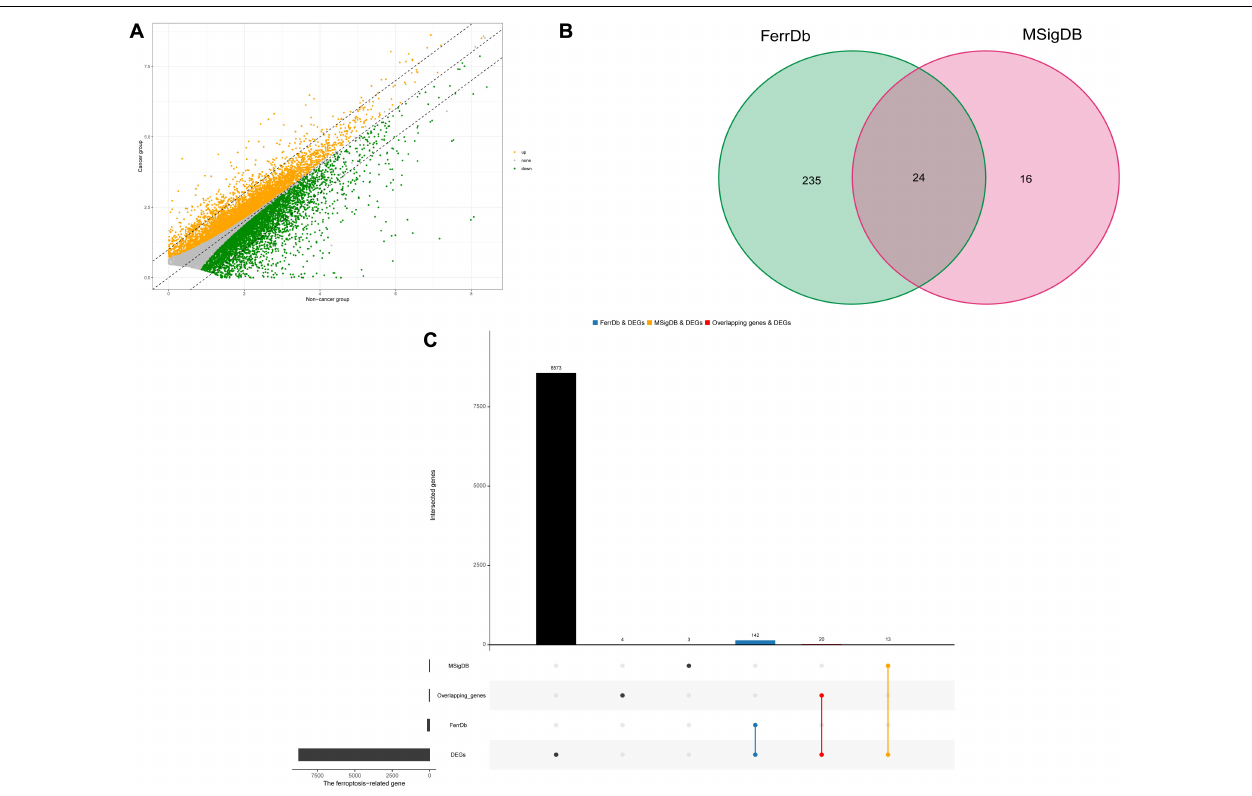
FIGURE 1 | Identification of differential expressed ferroptosis-related genes in HNSCC. (A) Differential expressed genes (DEGs) of head and neck squamous cell carcinoma (HNSCC). (B) Venn diagram of ferroptosis-related gene sets. (C) The blue and orange bars represents the unique DEGs related to ferroptosis in HNSCC in the FerrDb and MSigDB, respectively, and the red bar represents the overlapping DEGs related to ferroptosis in HNSCC between the FerrDb and MSigDB.